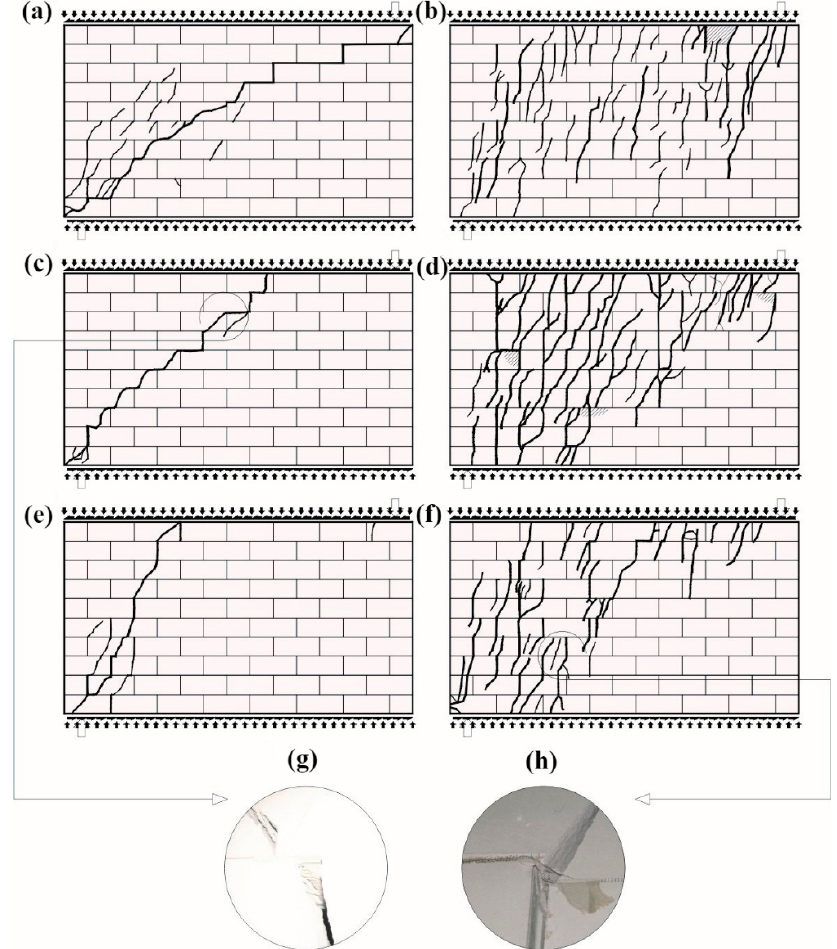
Figure 9. Cracking patterns of HOS-AAC series walls at the time of failure: ( a ) unreinforced shear wall at σ c = 0.1 N / mm 2 , ( b ) unreinforced shear wall at σ c = 1.0 N / mm 2 , ( c ) shear wall reinforced with steel trusses at σ c = 0.1 N / mm 2 , ( d ) shear wall reinforced with steel trusses at σ c = 1.0 N / mm 2 , ( e ) shear wall reinforced with plastic mesh at σ c = 0.1 N / mm 2 , ( f ) shear wall reinforced with plastic mesh at σ c = 1.0 N / mm 2 , ( g ) a broken truss, and ( h ) a broken plastic grid in the crush zone of a wall.